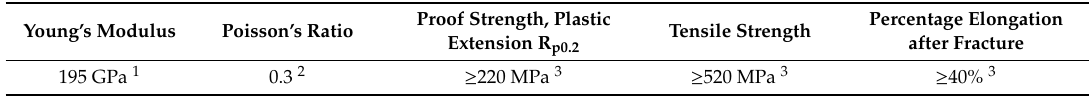
Table 2. Mechanical properties of S30408 at the room